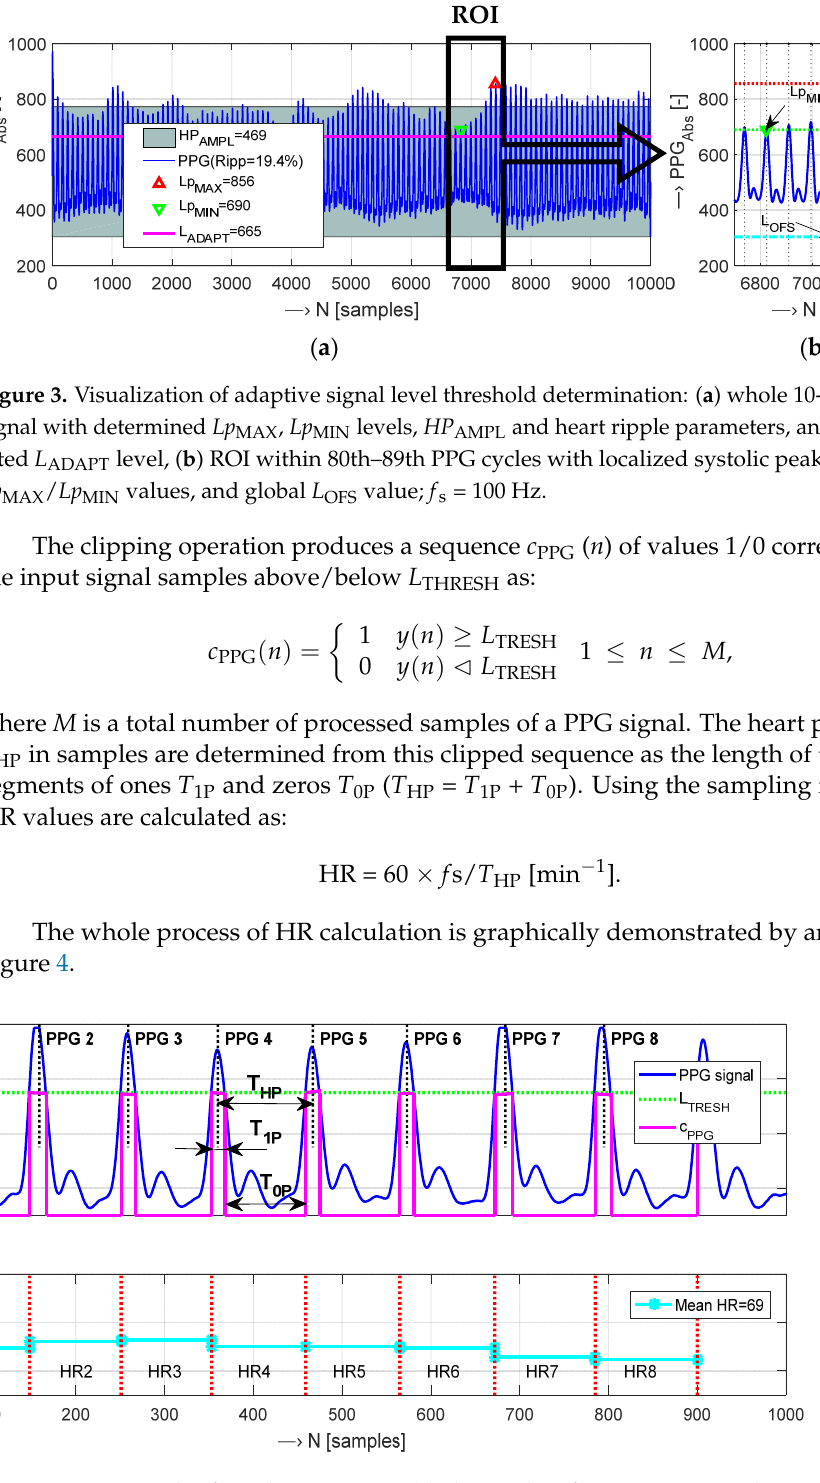
Figure 4. An example of HR determination: ( a ) 1k-samples of a PPG wave together with signed heart pulse periods T HP , lengths T 1P, T 0P , and a clipped sequence c PPG ( b ) HR values corresponding to periods T HP together with a final mean HR; L THRESH = 750, f s = 125 Hz.